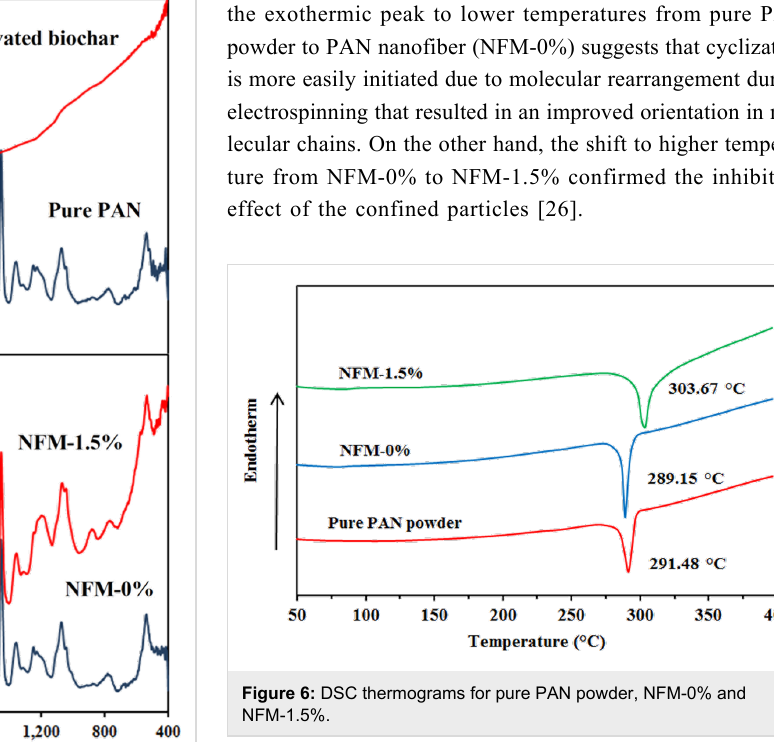
1072 cm − 1 , 1453 cm − 1 and 2940 cm − 1 are representative for